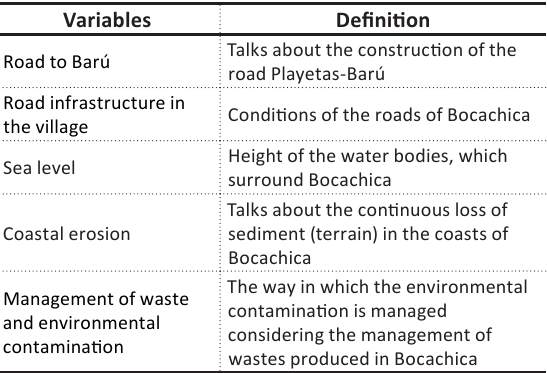
Table 6. Legal dimension